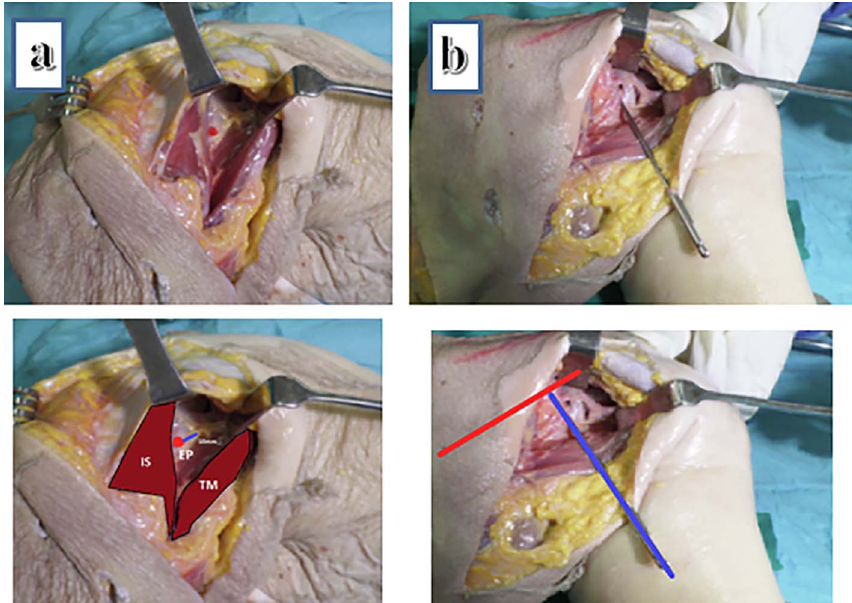
Figure 3. Cadaver specimen trial of screw application (Right shoulder specimen). (a) Entry point (EP), being the mean of all CT measurements, marked on the posterior scapular neck (red dot) 10 mm from glenoid rim (blue line) through a posterior surgical (Brodsky) approach between infraspinatous (IS) and teres minor (TM) muscles. (b) Ideal drill bit trajectory (blue line) in coronal plane referencing the para-coronal angle from scapular spine (red line) while the sagittal plane control is done under fl uoroscopic guidance.